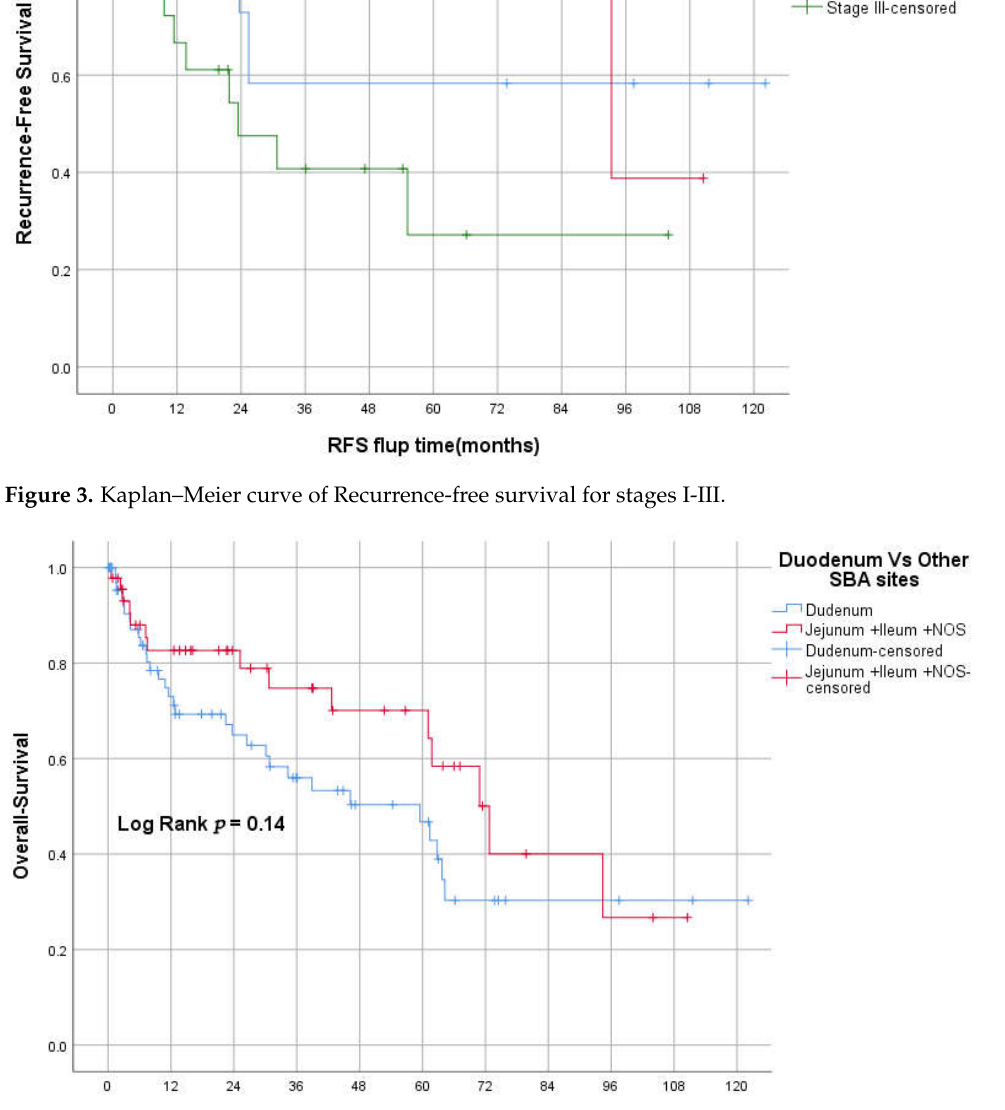
Figure 4. Kaplan–Meier curve of OS for duodenum vs. other SBA sites.